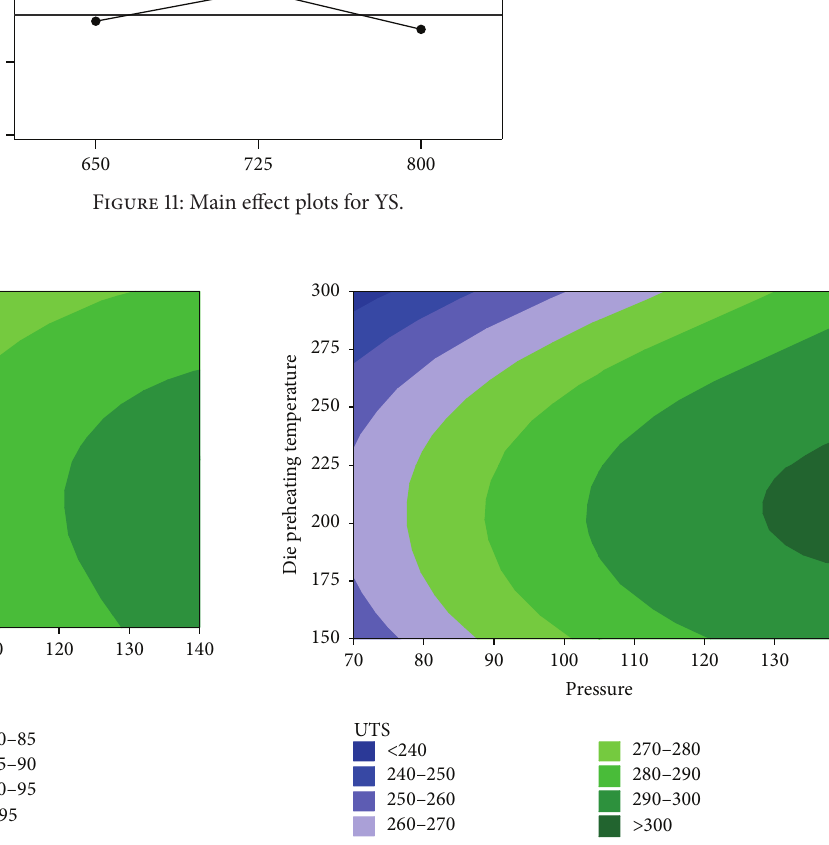
Figure12:Contourplotforhardnessversusdiepreheatingtempand pressure.